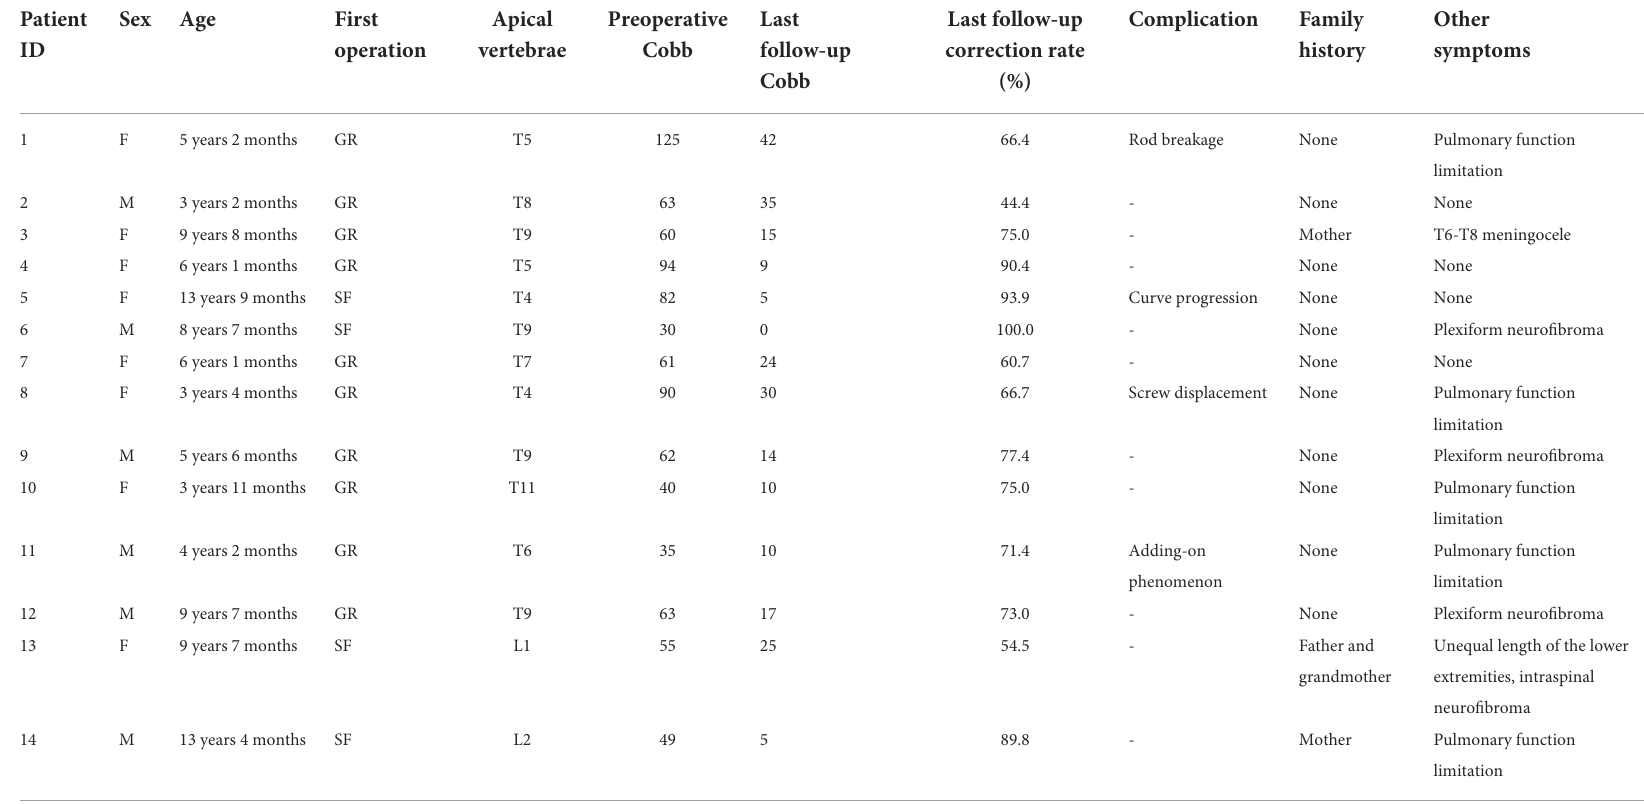
TABLE 1 Clinical information of 14 patients with NF1 associated dystrophic